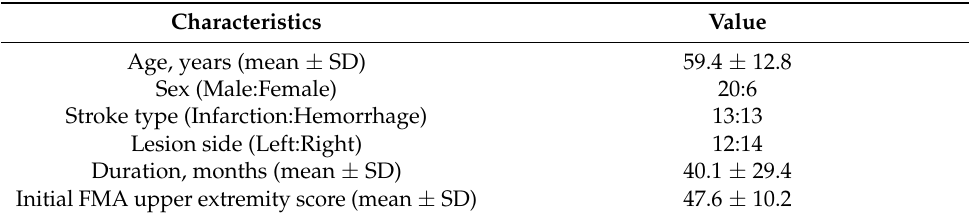
Table 1. Basic patient characteristics.